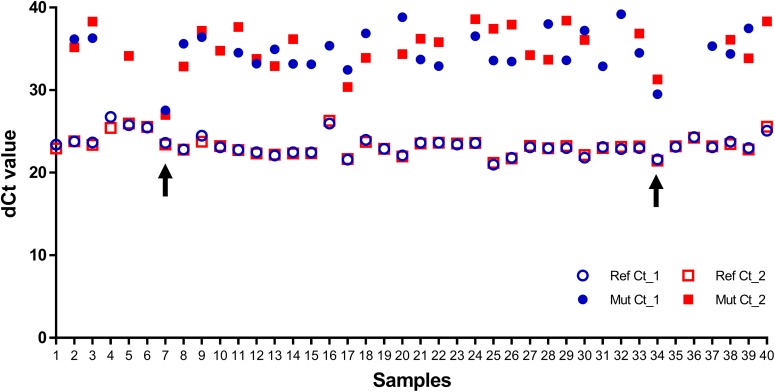
Ct values of duplicate assays showing intra-assay agreement.All samples were performed in duplicate, resulting in two Ct values for the Gene Reference Assay (open circle) and two Ct values for the Mutant Allele Assay (closed circle). The blue circles show the Ct values obtained in the first experiment, and the red circles show the Ct values obtained in the second experiment. Absence of a closed circle for a particular sample indicates that no Ct value was detected. The two samples in which the AKT1 E17K mutation was detected (samples 7 and 41 with a ΔCt <8.1) are indicated with an arrow.